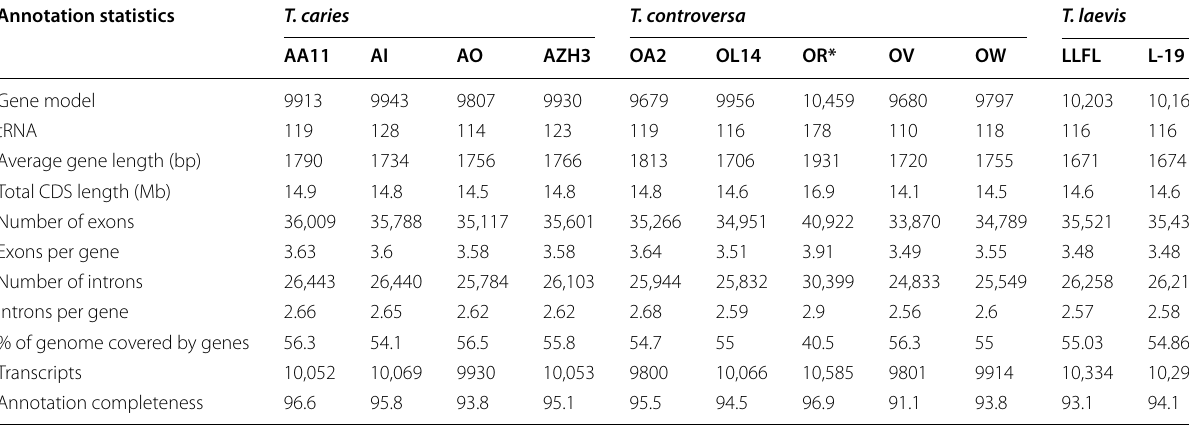
Table 2 Summary of gene model prediction